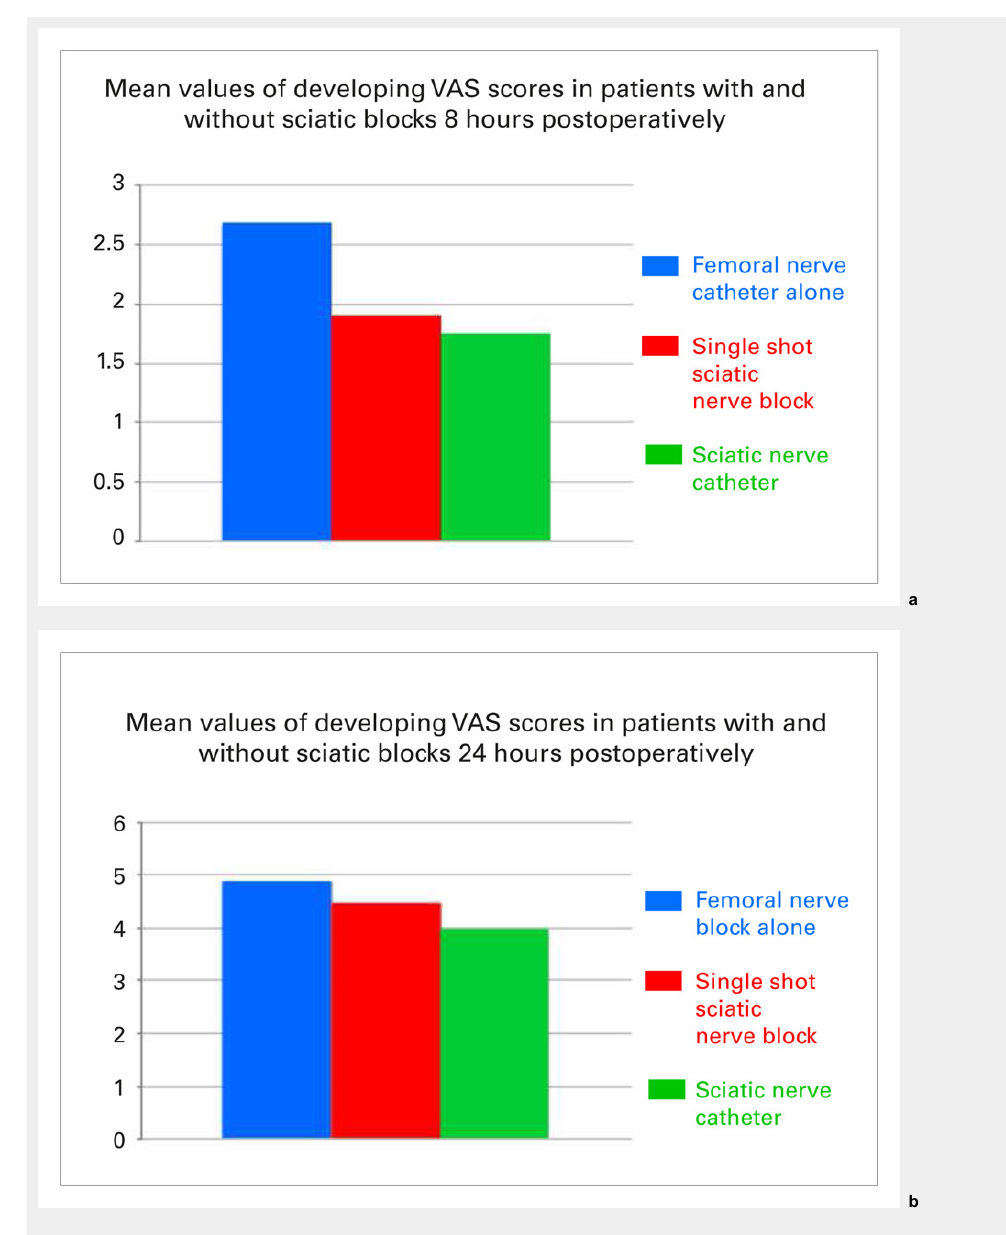
Figure 3 Mean values of developing VAS scores in patients with and without a sciatic blocks at 8 hours (a, above) and 24 hours (b, below)